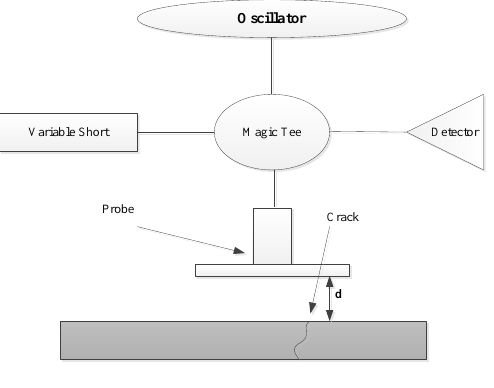
Figure 3. Measurement setup.